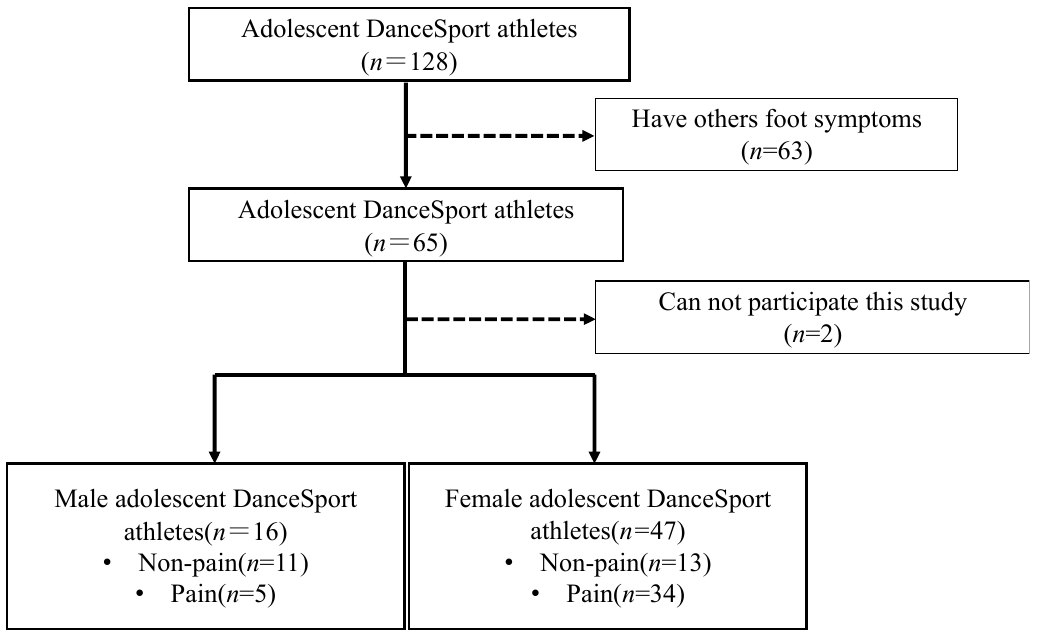
Figure 1. Process flowchart for the classification of groups based on the participants’ conditions.